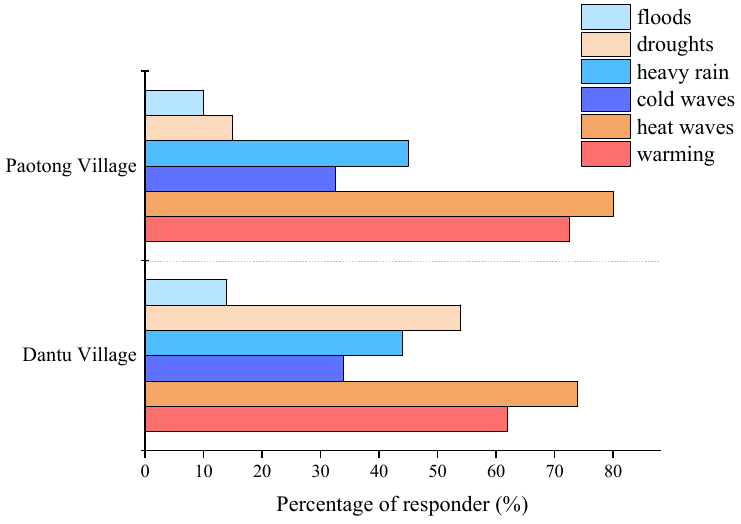
Figure 6. Respondents’ perception to climate change and weather extremes.